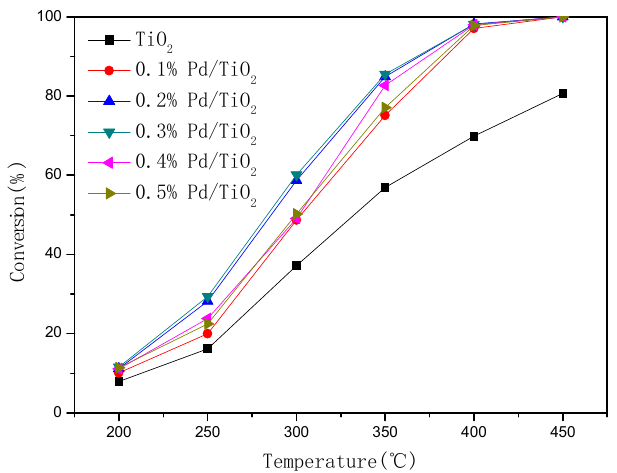
Figure 7. CB conversion of the x% Pd/TiO 2 catalysts with different Pd content. CB concentration = 2500mg/m 3 ; GHSV = 30,000 h −1 ; catalyst amount = 2 g.